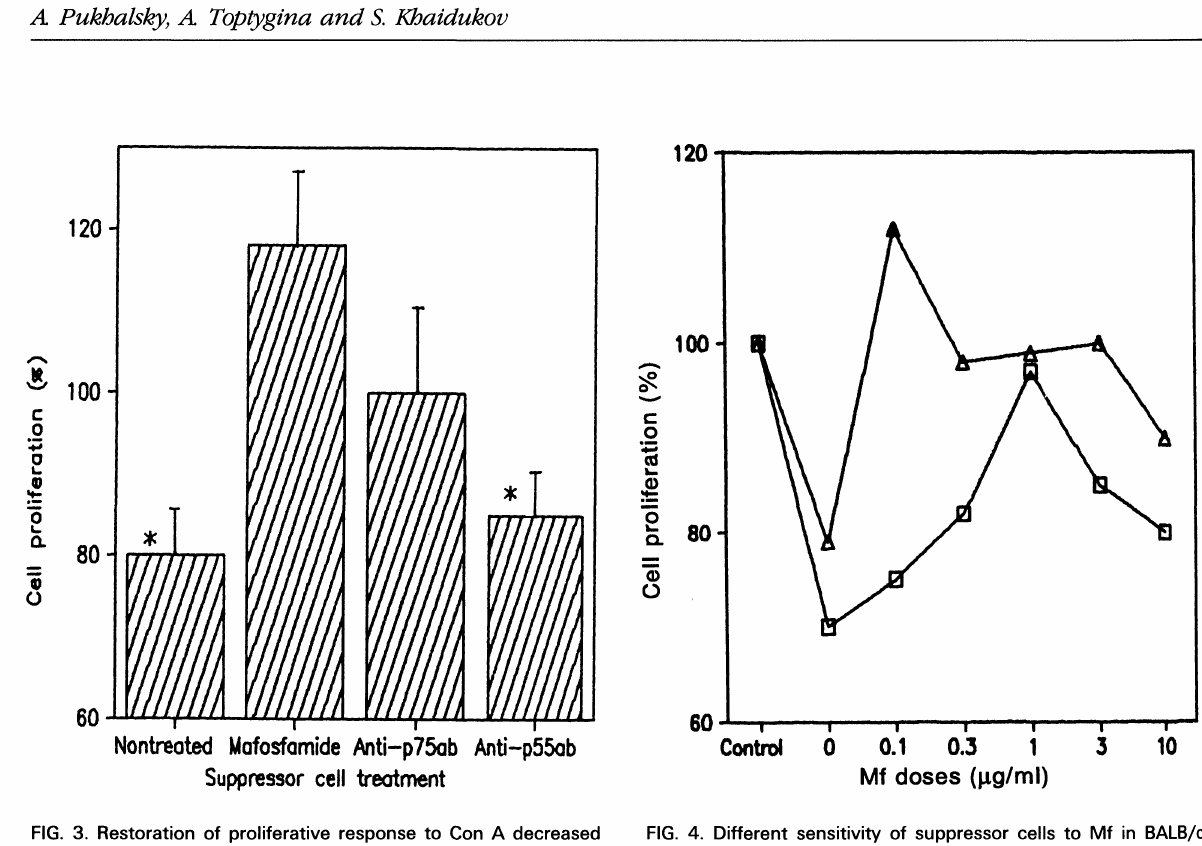
FIG. 3. Restoration of proliferative response to Con A decreased by IL-2-stimulated suppressor cells with MF or anti-p75 mono- clonal antibodies in DBA/2 mice. Proliferative response of spleen cells cultivated without IL-2-stimulated cells is taken as 100%. *p < 0.05.